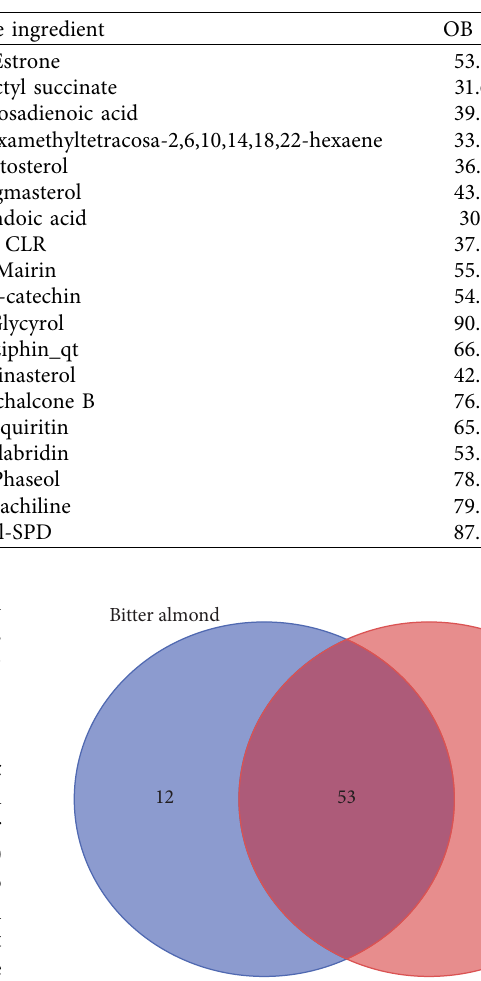
Table 1: Table of the main active ingredients of bitter almonds.